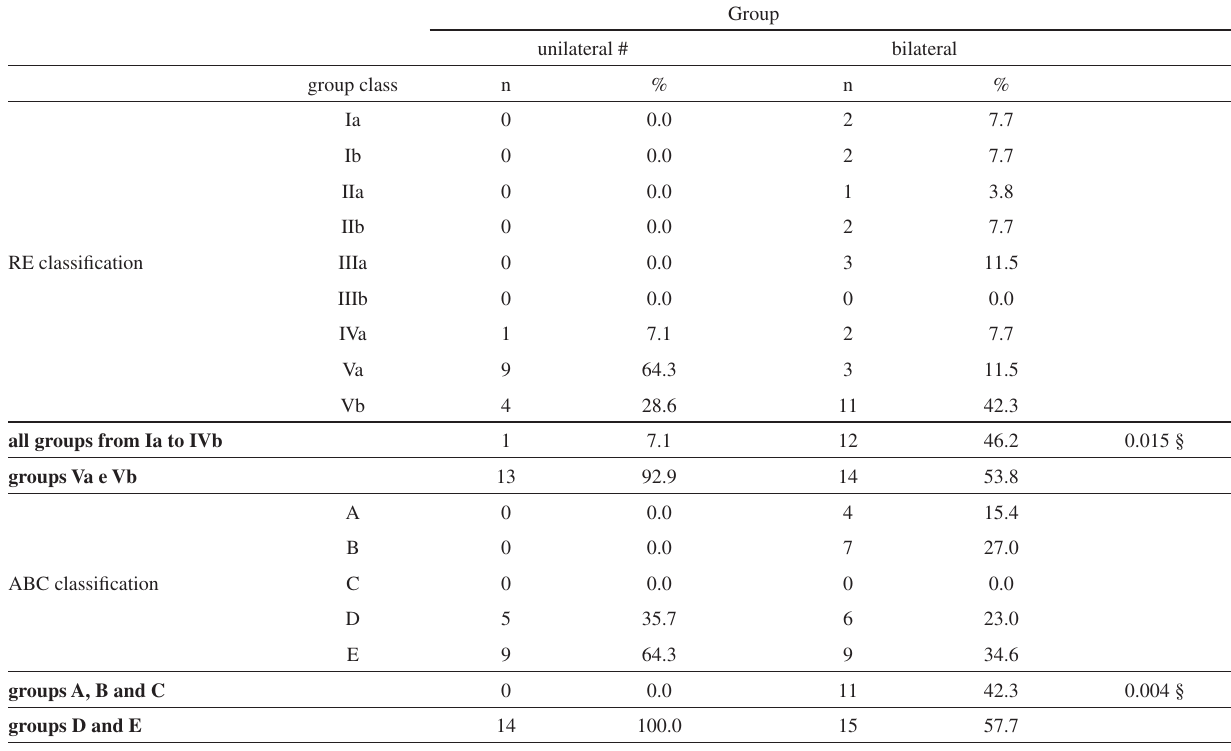
Table 3 - Reese-Ellsworth (RE) and Murphree ABC classification for all patients. Between the horizontal bars the eyes are grouped using the RE clas- sification (first interval), in less advanced retinoblastoma (RE: Ia to IVb) and more advanced tumor (RE:Va and Vb), and using the ABC classification (second interval), in less advanced retinoblastoma (A,B,and C) and more advanced tumor (D and E). There is a difference between the two groups when the number of eyes is considered